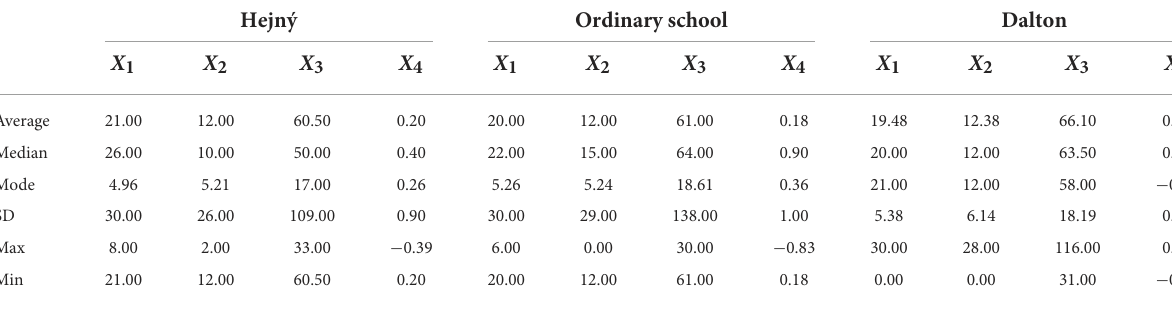
TABLE 1 Descriptive analysis according to the preferred learning management strategies at different types of schools.